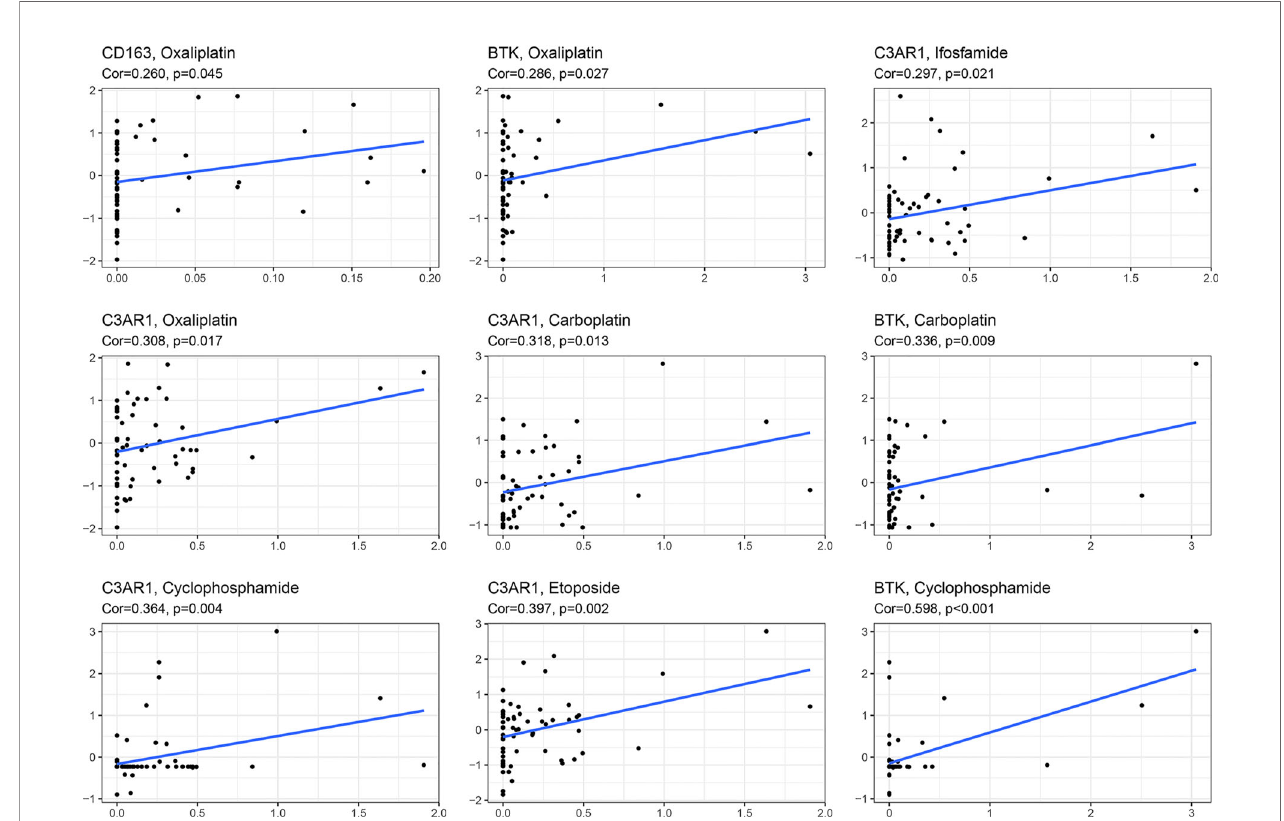
FIGURE 8 | Sensitivity analysis of key IRGs expression within different chemotherapeutic